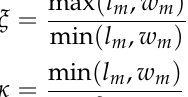
Figure 3. Contours corresponding to ε A 3000 Hz in steps of 300 Hz assuming µ r = 1.04 and σ m = 694 kS/m. The arrow denotes the direction of increasing ω ν . Note that the contours ε A m